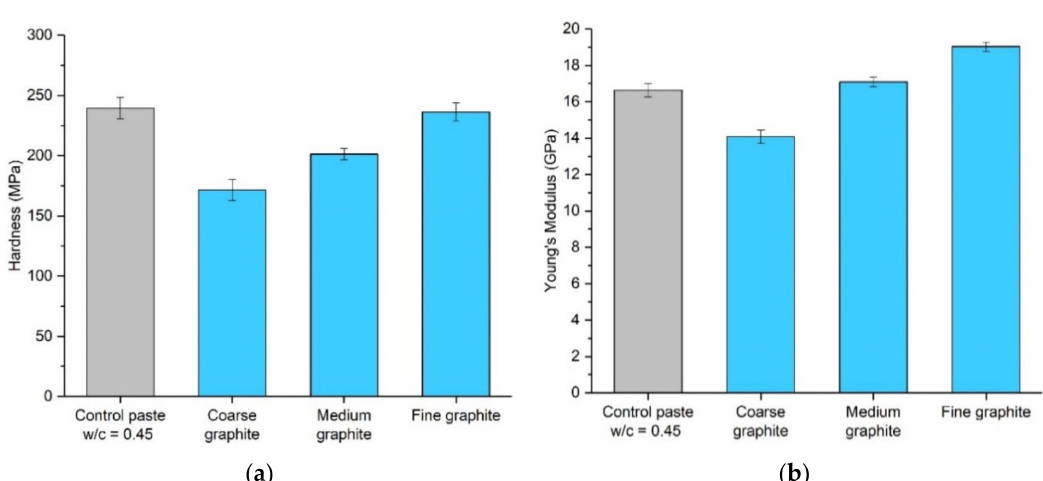
Figure 9. Micro-indentation results of the e ff ect of 20 wt % graphite addition on the cement paste, at 56 days, in terms of ( a ) hardness ( b ) and Young’s